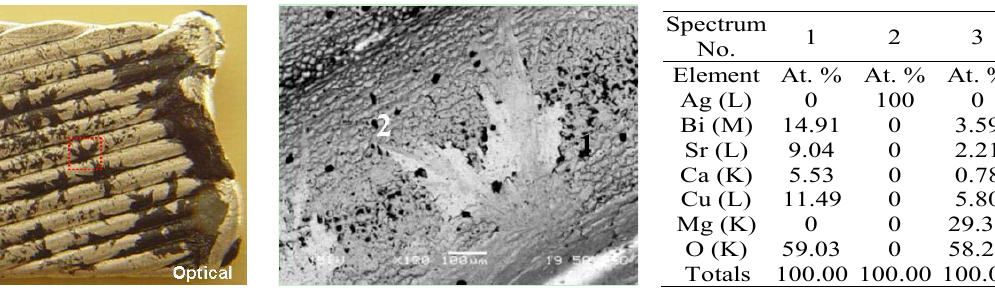
Figure 9. Bi ‐ 2212 Rutherford cable after reaction ( left ), back scatter image of circled black spot ( center ), and composition Table in marked locations ( right ) [15].